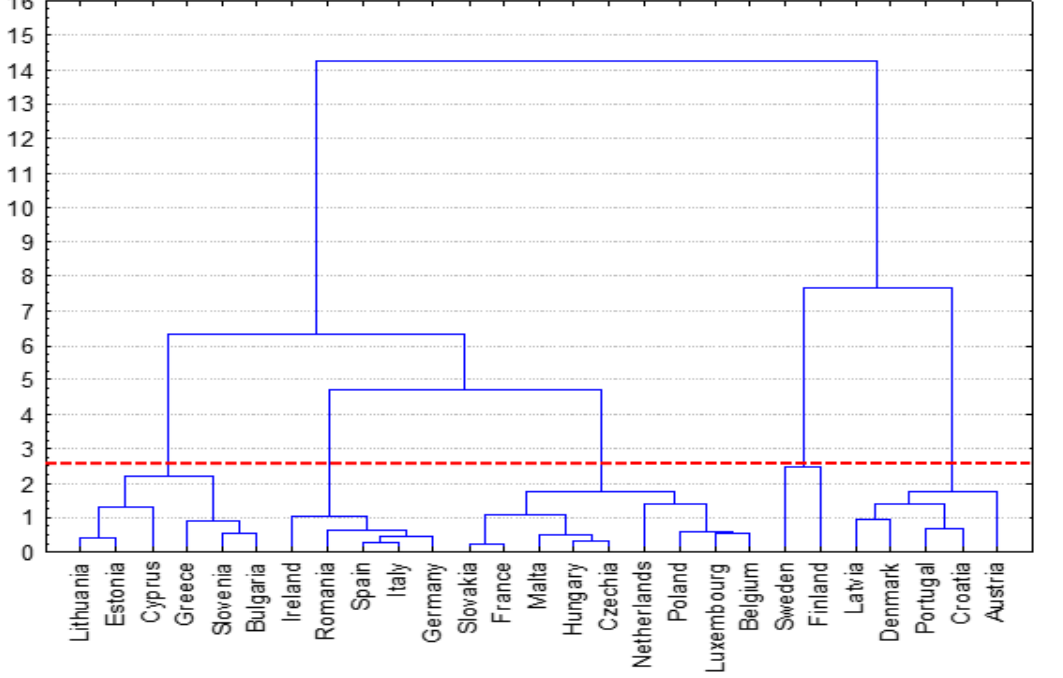
Figure 4. Graph of amalgamation schedule. The key to interpreting a hierarchical cluster analysis is to look at the point at which any given pair of countries “join together” in the tree diagram. Countries that join together